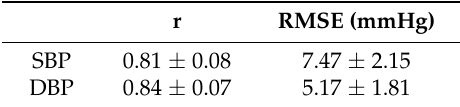
Figure 13. Representative correlation plots between calculated PWV and reference BP.